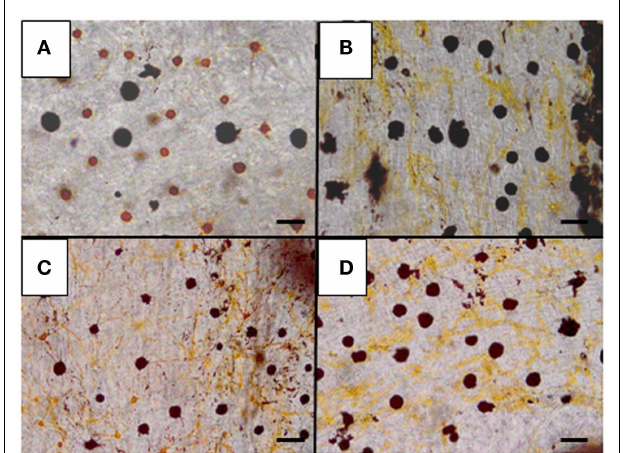
FIGURE 4 | Effects of α -MSH on pigment dispersion in chromatophores in the skin of barfin flounder . A control skin specimen was incubated in medium containing no α -MSH (A) . Skin specimens were treated with 10nM (B) , 100nM (C) , and 1 µ M α -MSH (D) at 16°C for 1h. Pigments in melanophores did not migrate, whereas those in xanthophores diffused. See Kobayashi et al. (71) for details.The bar equals 100 µ